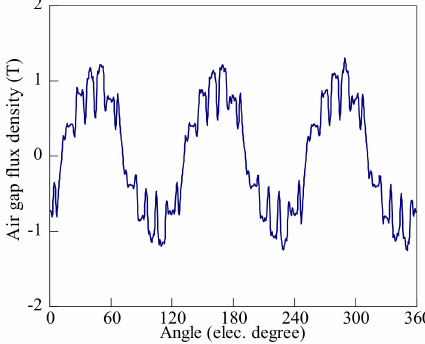
Figure 4. Radial air gap flux density under rated-load condition.